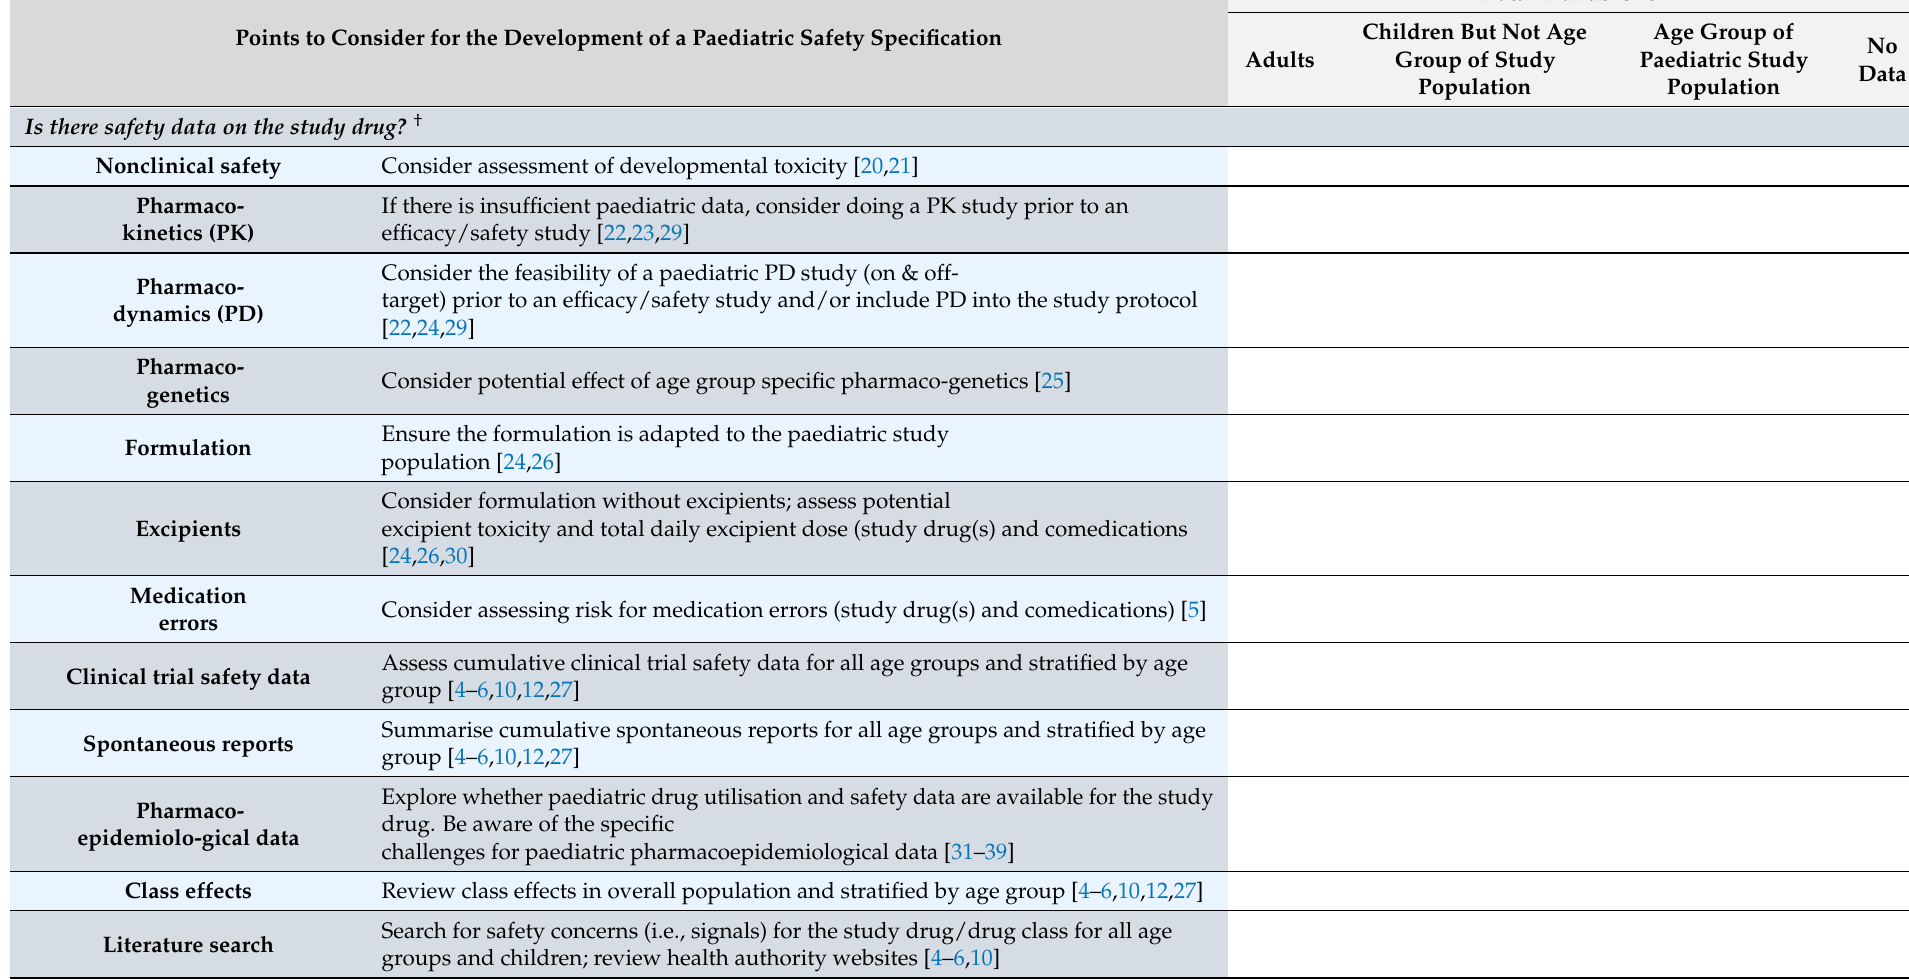
Table 1. Proposal for a checklist for the development of a paediatric safety specification (not exhaustive). Points to Consider for the Development of a Paediatric Safety Specification